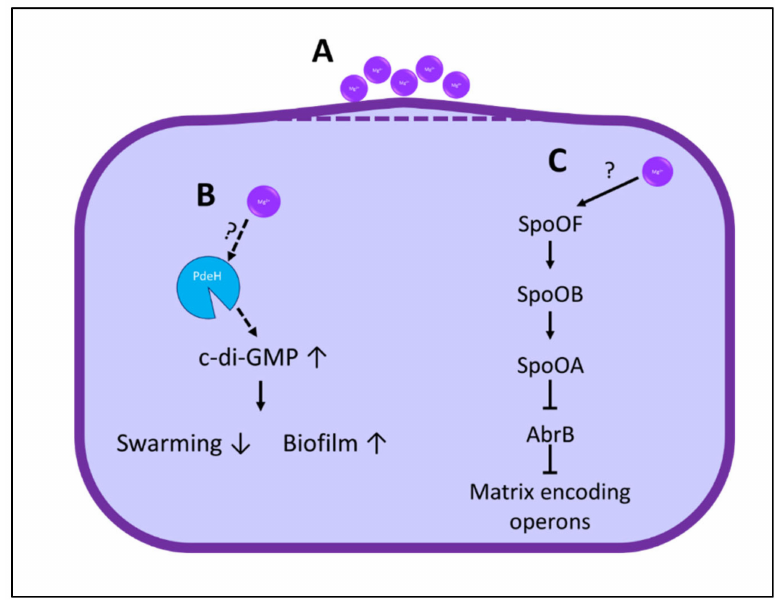
Figure 1. Possible mechanisms for the influence of Mg 2 + ions on biofilm formation. A : Mg 2 + can a ff ect the membranes curvature, which results in a more sensitive bacterial population. B : Elevation of c-di-GMP levels leads to inhibition of the swarming motility and increased biofilm